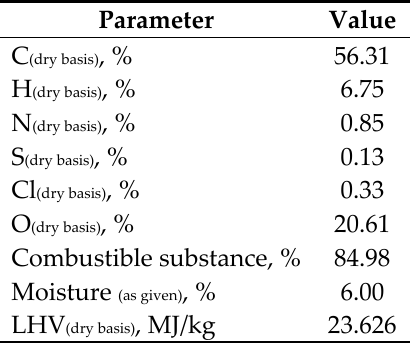
Table 1. Fuel analysis measurements.